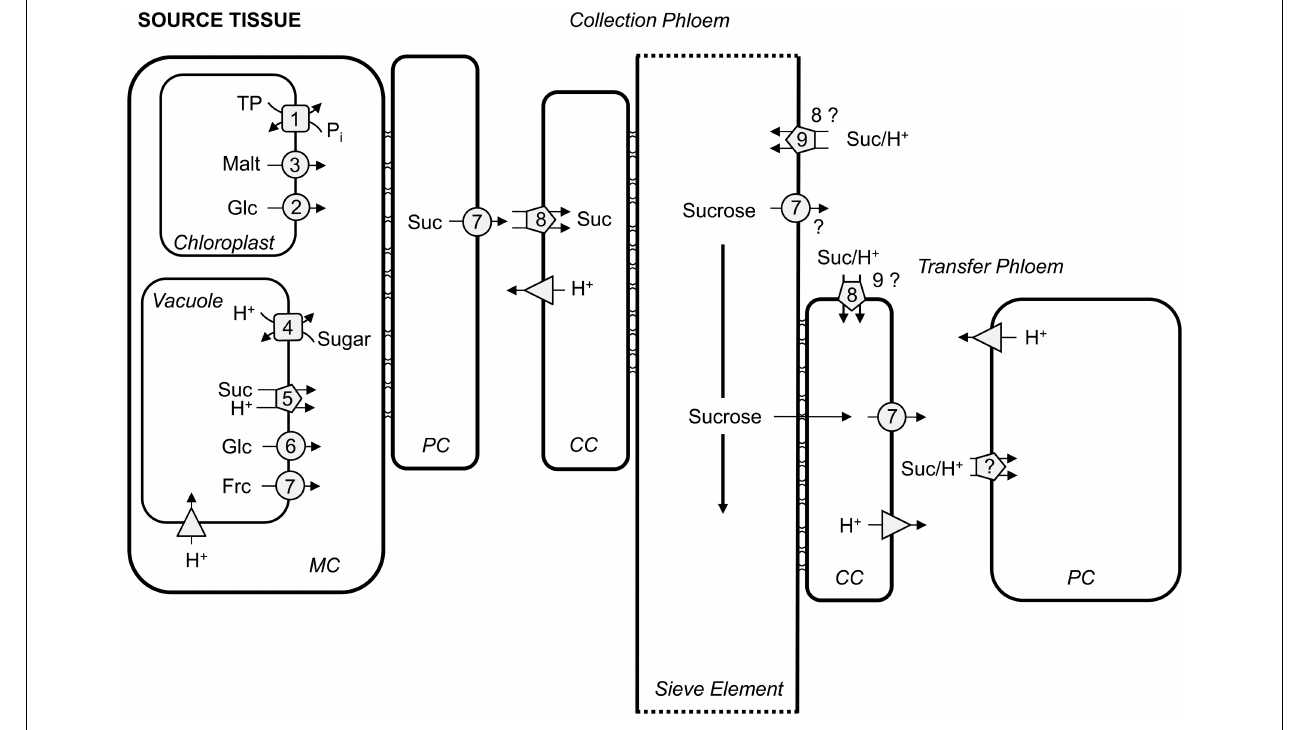
pentagons depict symporters, and triangles H + -ATPases/PPases. 1,TPT; 2, pGlcT; 3, MEX; 4,TMT andVGT; 5, SUC4/SUT4; 6, ESL1; 7, SWEETs; 8, SUC2/SUT1; 9, SUC3.TP, triose phosphates; Malt, maltose; Glc, glucose; Suc, sucrose; Frc, fructose. Please refer to text for transporter